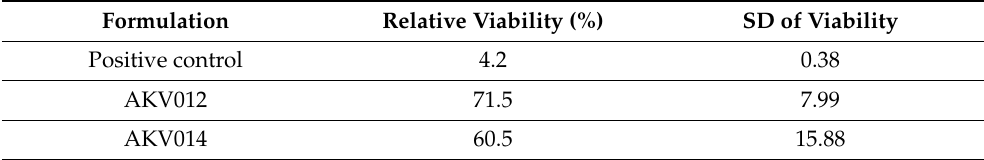
Table 6. Viability of reconstructed human epidermal after exposure to two AKVANO formulations and positive control, relative to the negative